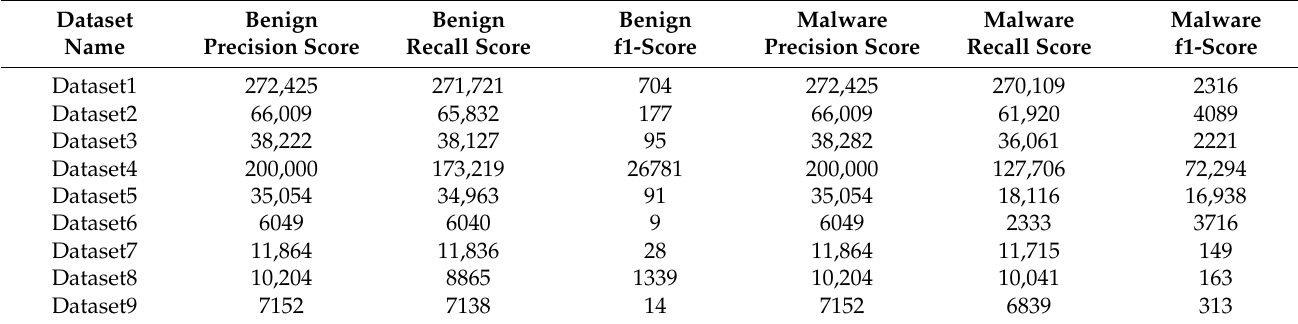
Table 6. Confusion matrix for testing with the decision tree algorithm.